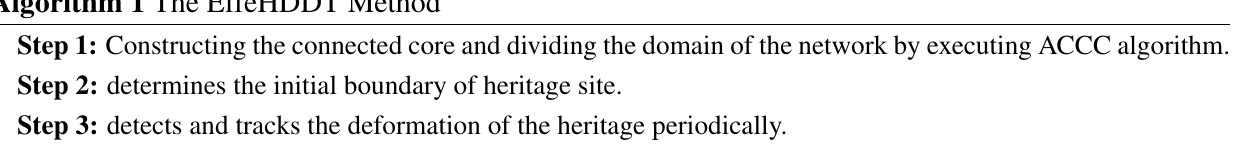
Algorithm 1 The EffeHDDT